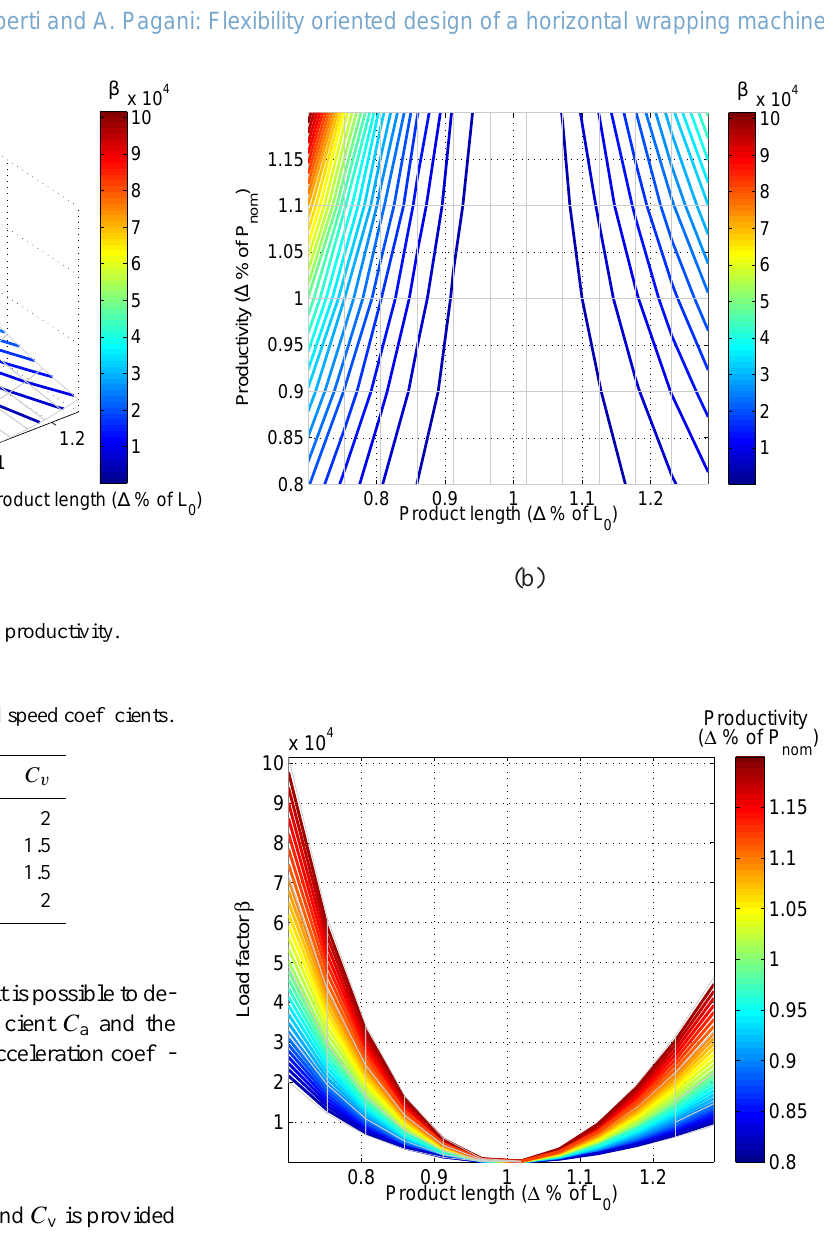
Figure 9. β as a function of product